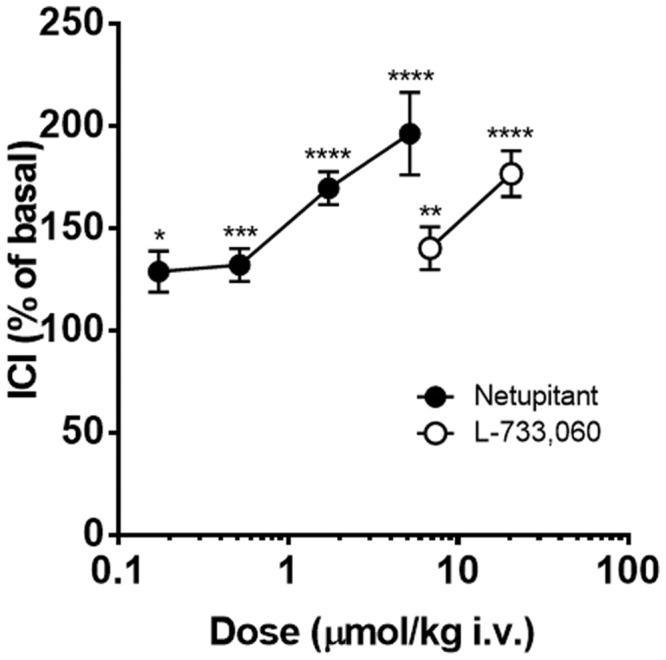
Continuous acetic acid infusion CMGs in female guinea-pigs. Graphs showing the effects of netupitant (n = 10 for each dose) or L-733,060 (n = 10 for each dose) on ICI. Doses of these drugs are expressed in μmol/kg to compare the potencies of these drugs on ICI. Asterisks indicate statistical difference from the basal (∗P < 0.05, ∗∗P < 0.01, ∗∗∗P < 0.001, ∗∗∗∗P < 0.0001, Sidak’s multiple comparison test following repeated measures two-way ANOVA). All statistical analyses were performed using actual values.